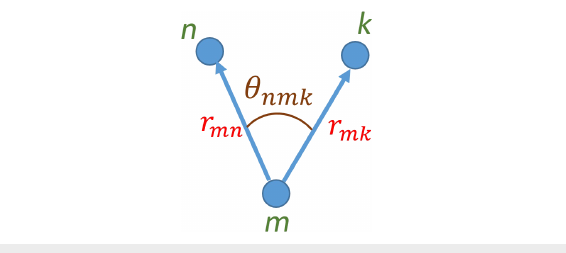
Figure 3: Bond lengths and bond angle for three neighboring atoms m , n , and k